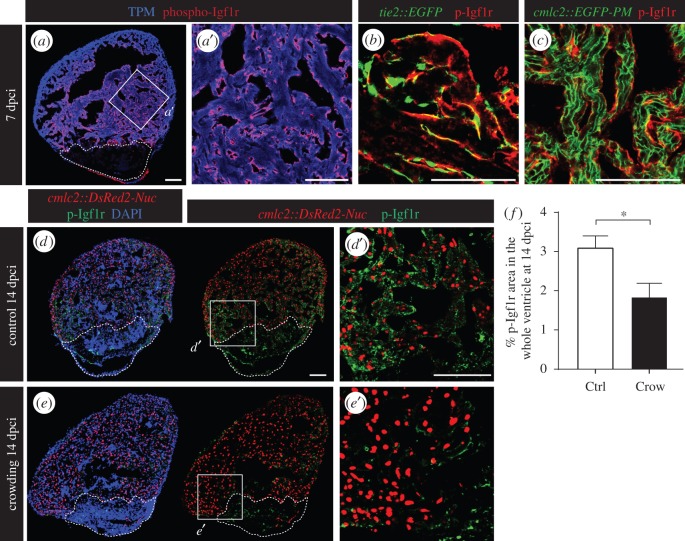
Daily stress decreases phospho-Igf1r activation in the regenerating heart. (a) Ventricular sections at 7 dpci reveal the presence of phospho-Igf1r (p-Igfr1, red) in the endocardium that covers cardiac muscle labelled by tropomyosin expression (TMP, blue). (b) p-Igf1r partially colocalizes with the pattern of endothelial cell layers demarcated by GFP expression in tie2::EGFP transgenic fish. (c) p-Igf1r does not overlap with the plasma membrane of CMs in cmlc2::EGFP-PM transgenic fish. (d,e) Sections of cmlc2::DsRed2-Nuc (red) hearts at 14 dpci display reduced p-Igf1r (green) expression in stressed animals. (f) Quantification of phospho-Igf1r area per ventricle at 14 dpci in control and stressed animals (N ≥ 7). *p < 0.05. Dashed lines encircle the cryoinjured areas. Scale bars, 100 µm.